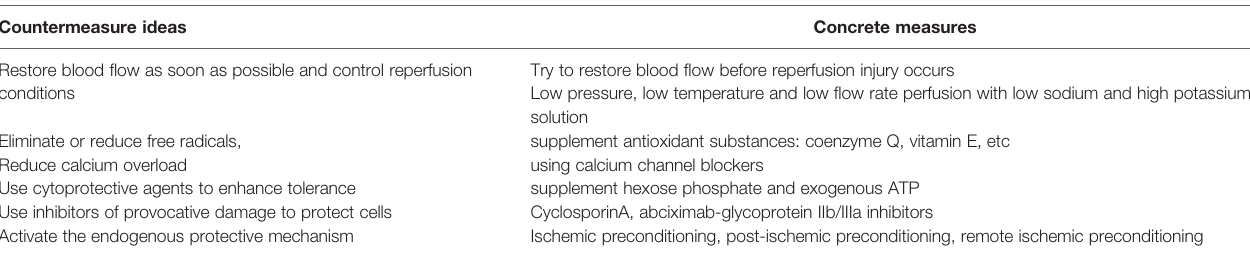
TABLE 1 | Treatment ideas and speci fi c measures for ischemia-reperfusion injury. Countermeasure ideas Concrete measures Restore blood fl ow as soon as possible and control reperfusion